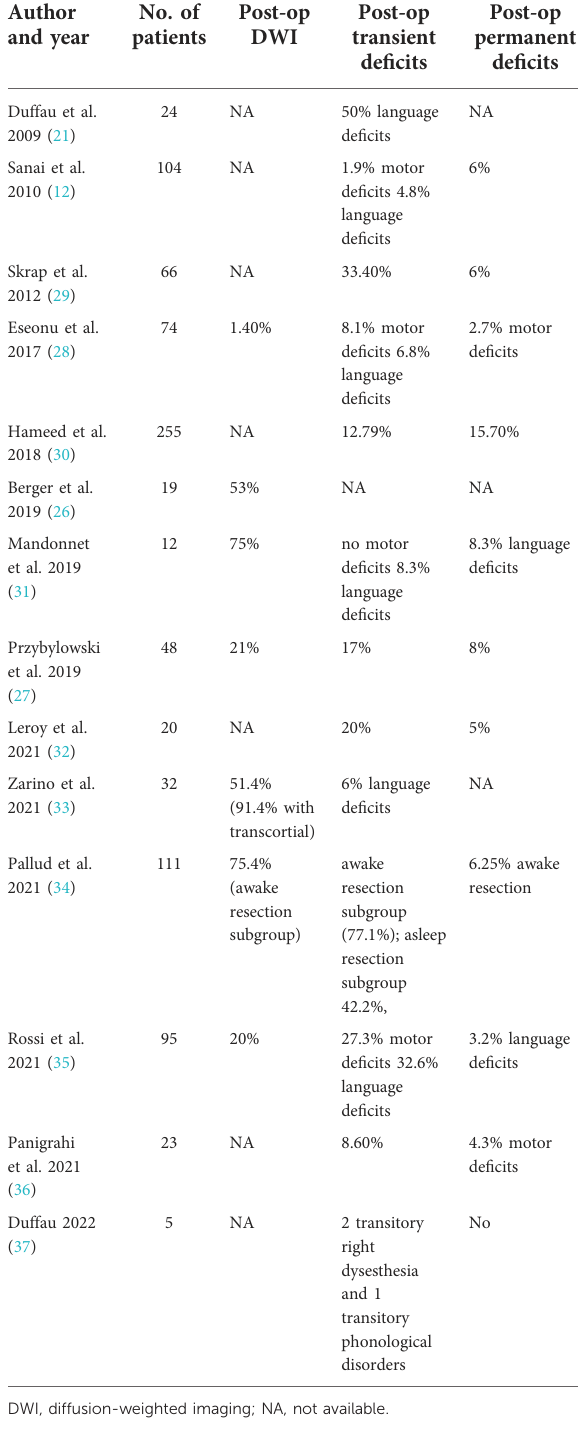
TABLE 5 Insular glioma resected with transcortical approach studies selected for